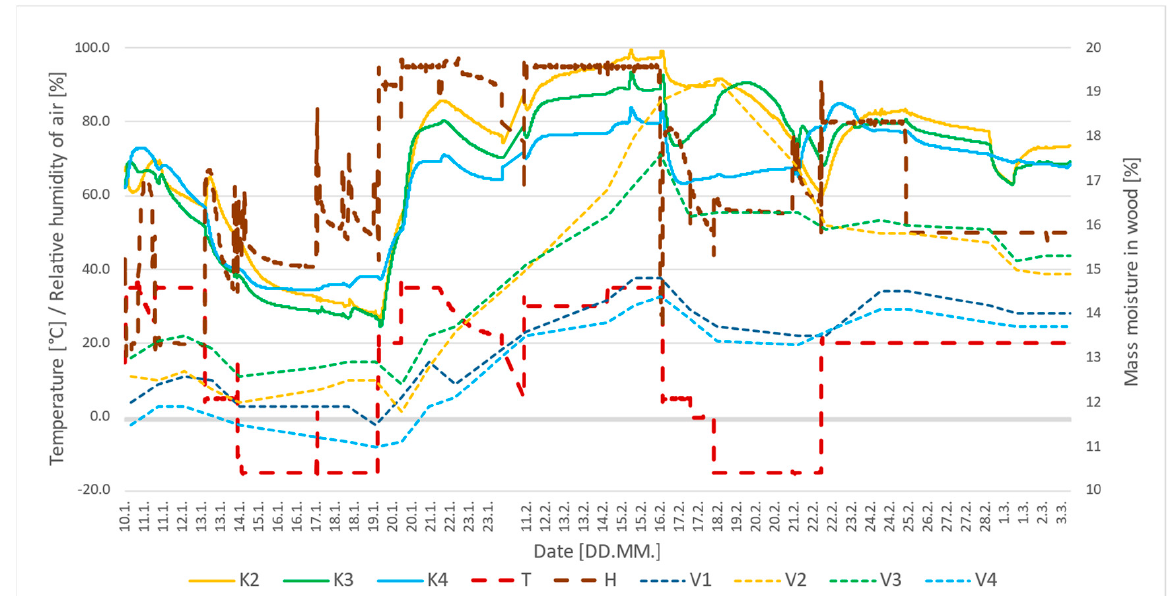
Figure 10. The course of temperature and humidity in the outdoor chamber during the experiment.